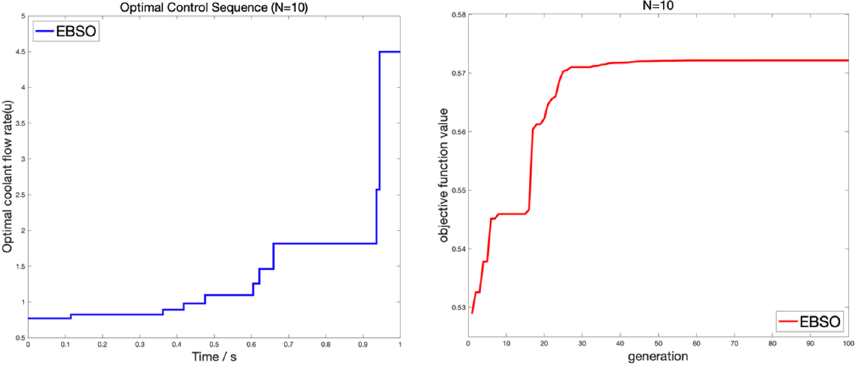
Figure 34. Optimal control trajectory and iteration curve ( N = 10). The optimal temperature control sequence and iterative convergence diagram of EBSO reaching the optimal concentration are shown in Figure 35 for when the number of segment points was N = 20 .